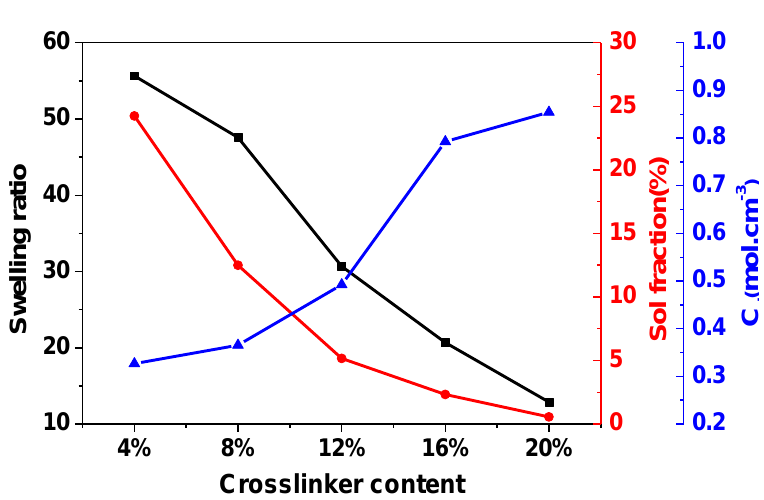
Figure 3 . The cross-linking density, swelling ratio, and sol fraction of the C-FPAE series with differ- ent BDB contents .